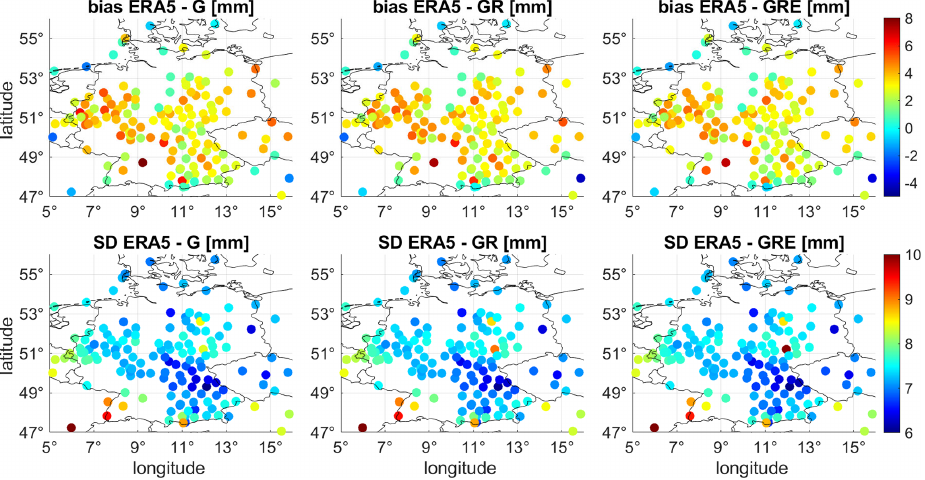
Figure 8. The map of ZTD biases and standard deviations between ERA5 and the three GNSS solutions for Germany. The values are averaged from the year 2020. The map shows only the GRE capable stations; thus there are gaps for some